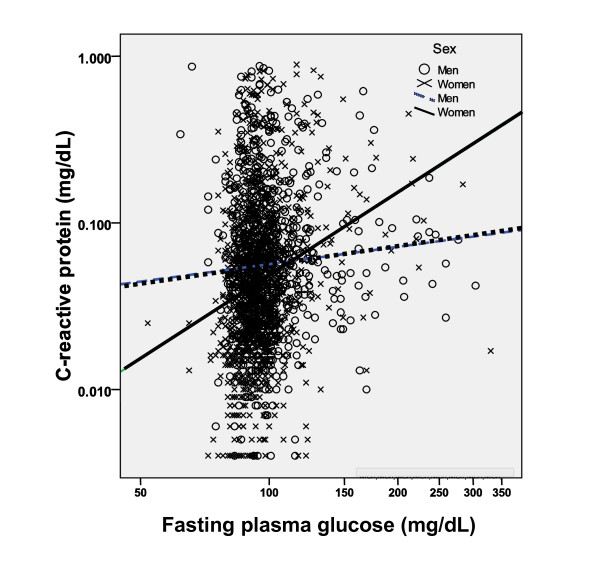
Relationship between fasting plasma glucose (FPG) and high sensitivity C-reactive protein (hsCRP) according to gender. In women, hsCRP increased significantly and progressively with increasing FPG (r = 0.169, P < 0.001). Test of significance was based on log-transformed values for analysis. P -value: Pearson's correlation coefficient.